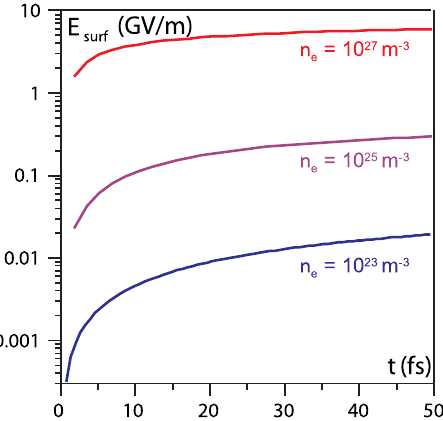
FIG. 4. Dependence of the electric field strength at the surface on time for different electron number densities (shown on the plot); T ¼ 1 eV .